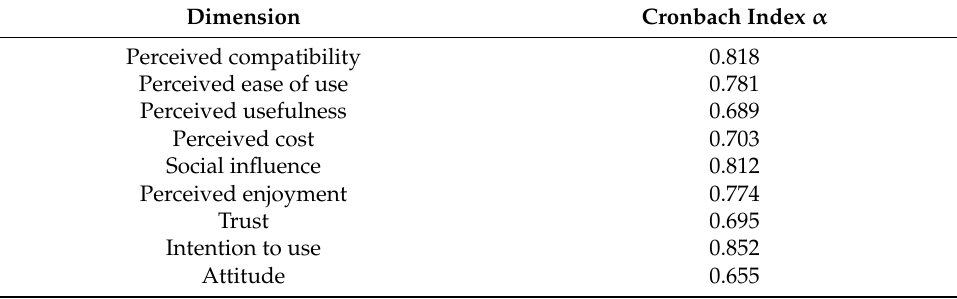
Table A11. Cronbach’s reliability coefficient results by dimension of the questionnaire.